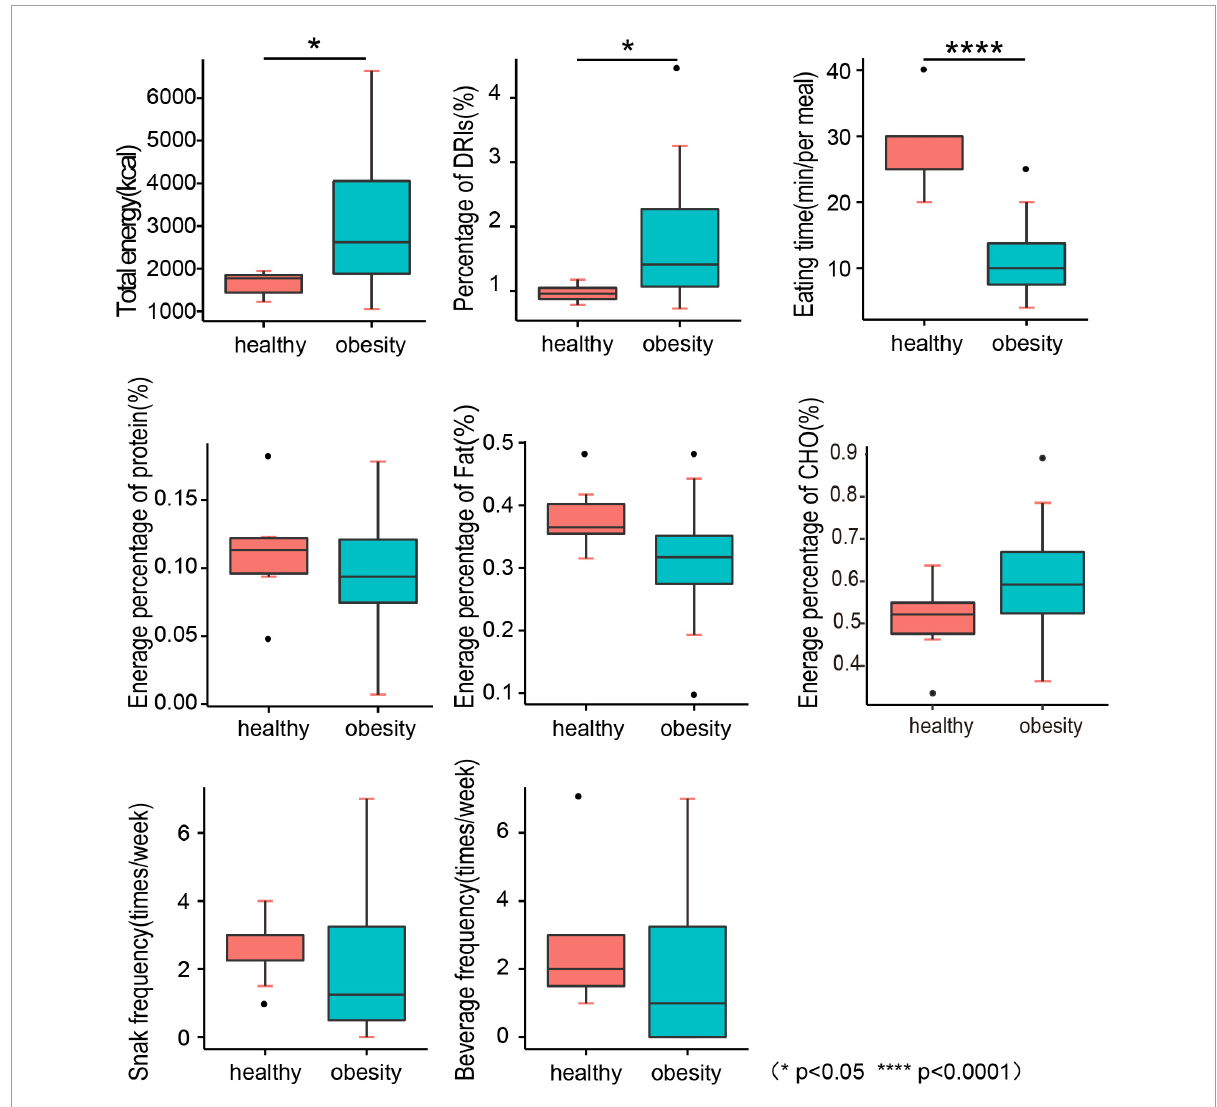
FIGURE2 Dietary survey and dietary behavior. DRIs, dietary reference intakes; CHO,